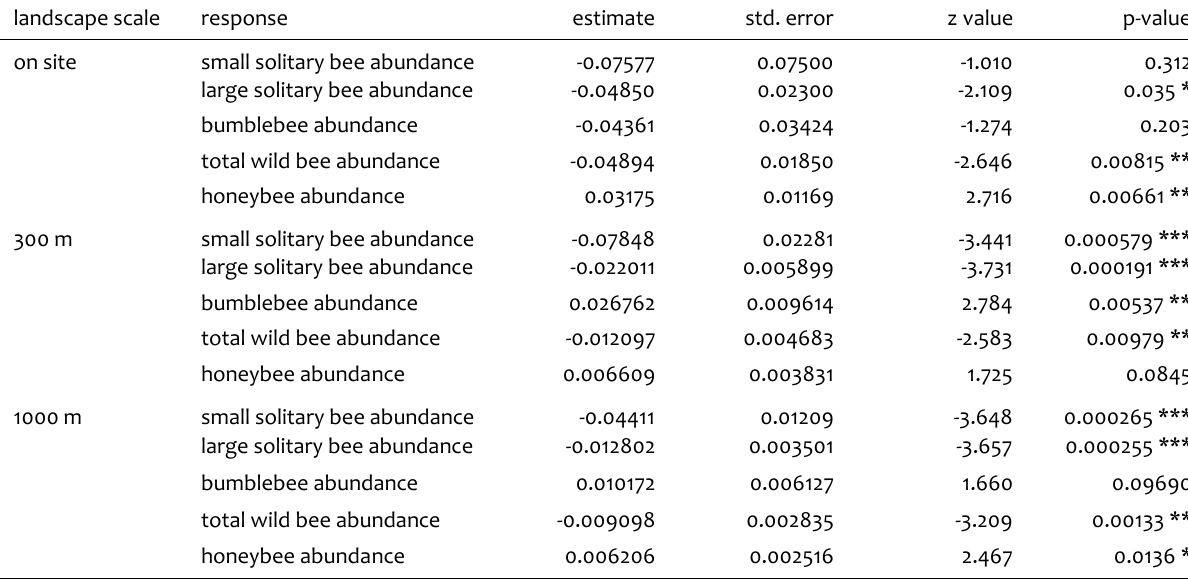
Table 8. Results of poisson regression models describing the effect of the number of honeybee hives at different landscape scales on wild bee and honeybee abundance on apple flowers. Each landscape scale and bee type represent a separate model. Estimated parameters, standard errors, z-values and p-values are given. Significance is marked with * at P  0.05, ** at P  0.01 and *** at P 